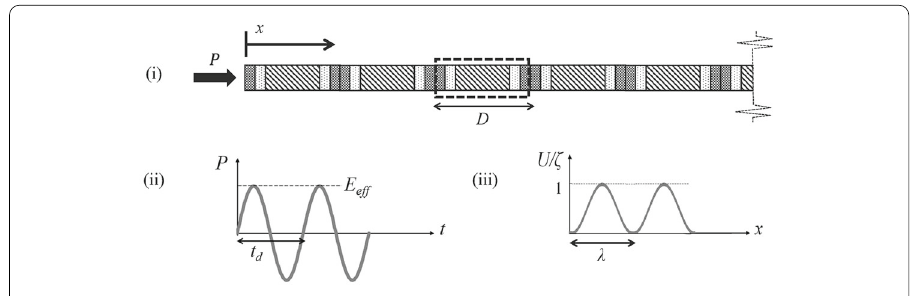
Fig. 5 i Schematics of a periodic layered composite bar with underlying unit cell of size D , subjected to a sinusoidal load P at x = 0 . ii Sinusoidal load P with amplitude E eff over two periods, 2 t d . iii